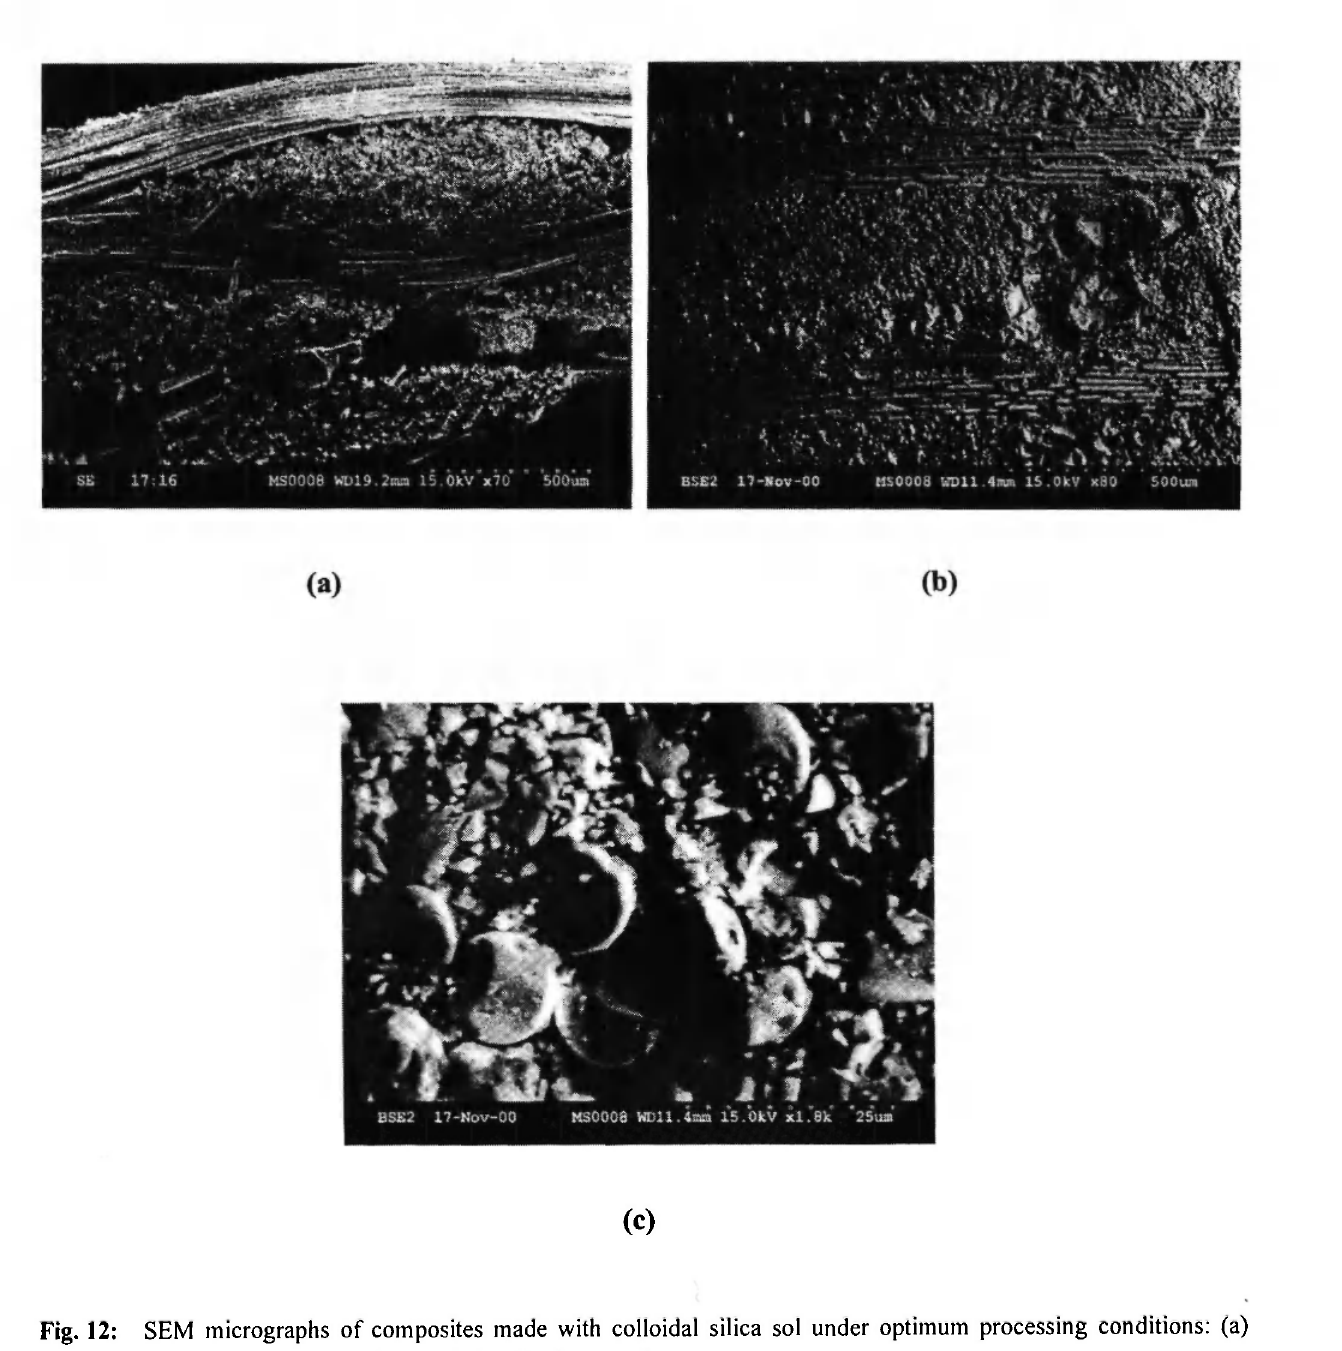
Fig. 12: SEM micrographs of composites made with colloidal silica sol under optimum processing conditions: (a) after one infiltration, (b) and (c) densified